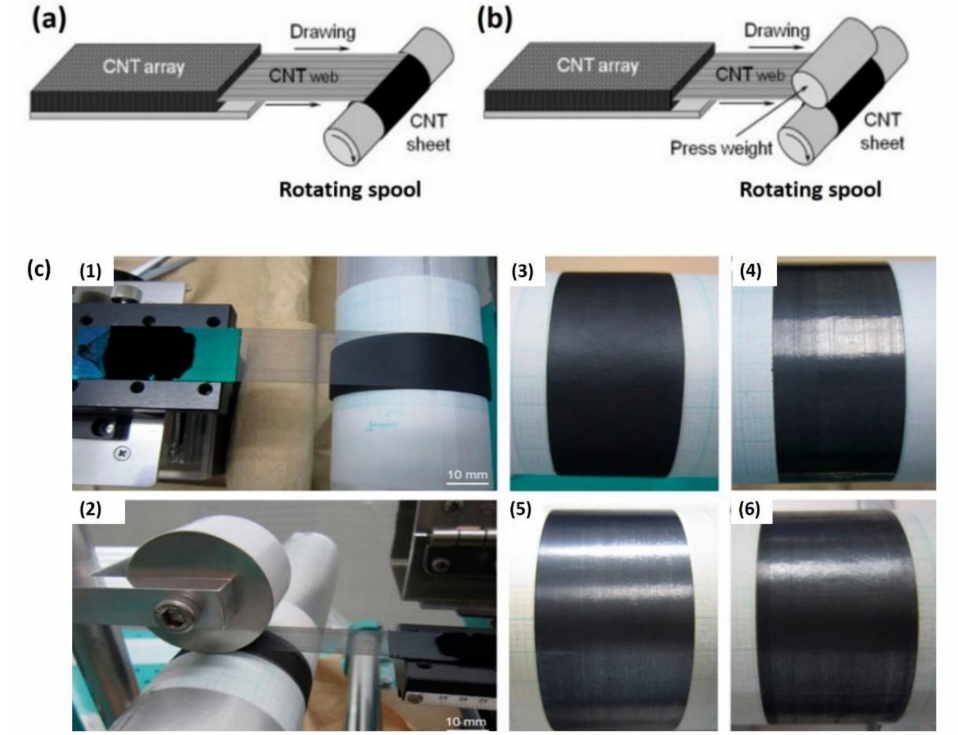
Figure 6. Schematic diagram showing aligned CNT sheet processing: ( a ) drawing and winding; ( b ) drawing, winding, and pressing (reproduced from [108]). ( c ) CNT sheet processing: (1) drawing and winding technique; (2) drawing, winding, and pressing process; (3) non-pressed CNT sheet; and (4–6) pressed CNT sheets under corresponding press load. Reproduced from